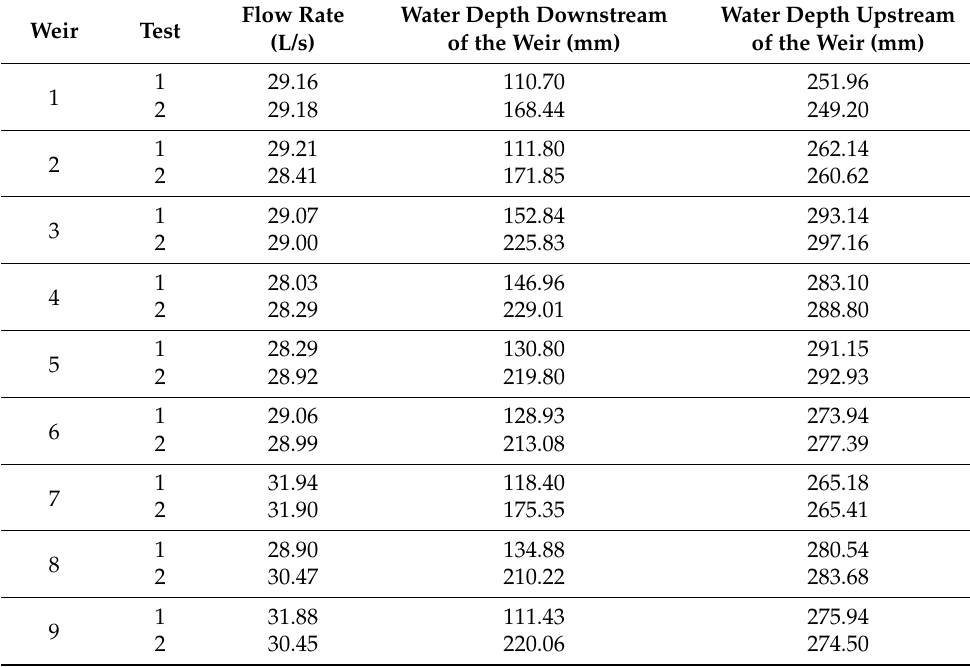
Table A3. Experimental data of the third experimental